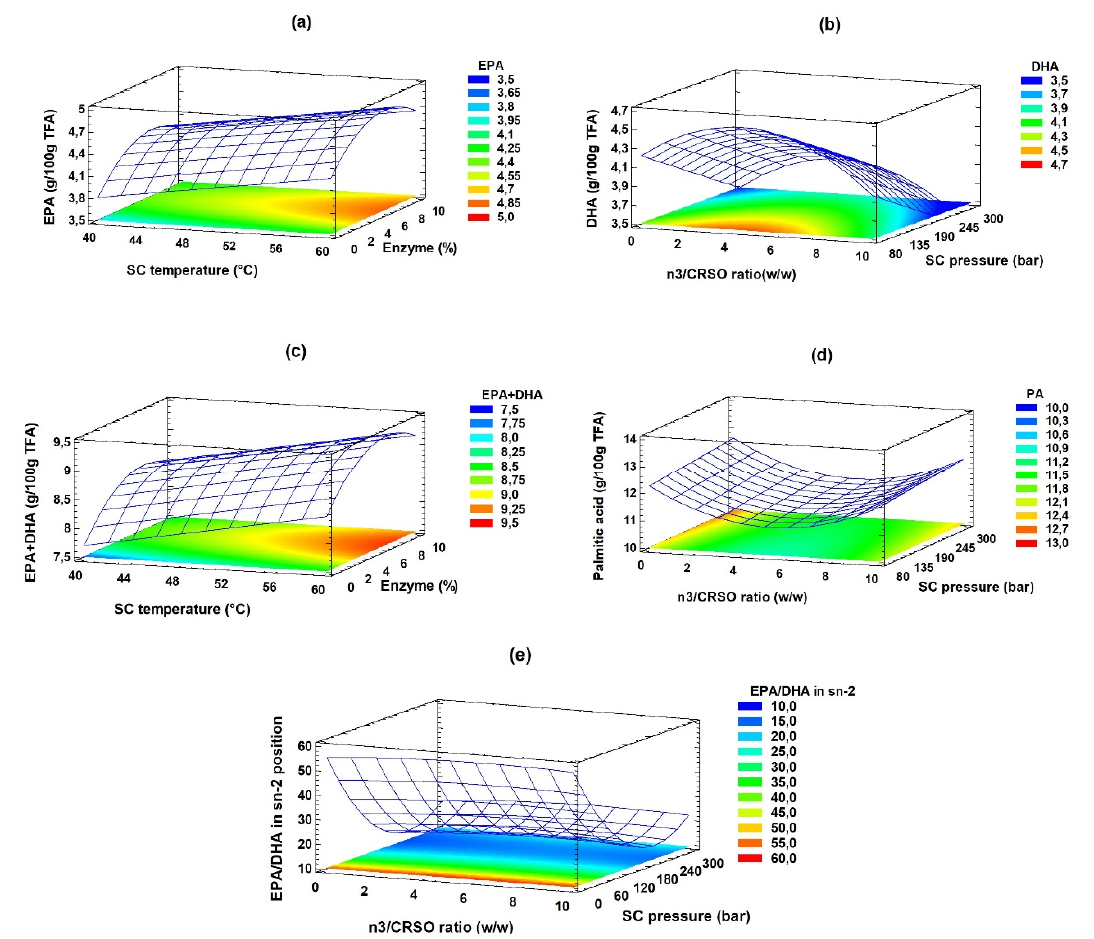
Figure 2. Effect of n -3/CRSO ratio, SC temperature, SC pressure, and amount of enzyme on the SAcyl synthesis process. Estimated response surface and contour response surface. Panels ( a – e ), represents EPA, DHA, EPA+DHA, PA, and EPA/DHA in sn -2, respectively. Table 2. Optimal values of the independent variables n -3/CRSO ratio, SC pressure, SC temperature, and enzyme percentage to maximize the EPA, DHA, EPA + DHA, and EPA/DHA in sn -2 responses by SAcyl, and the multi-response optimization of these variables